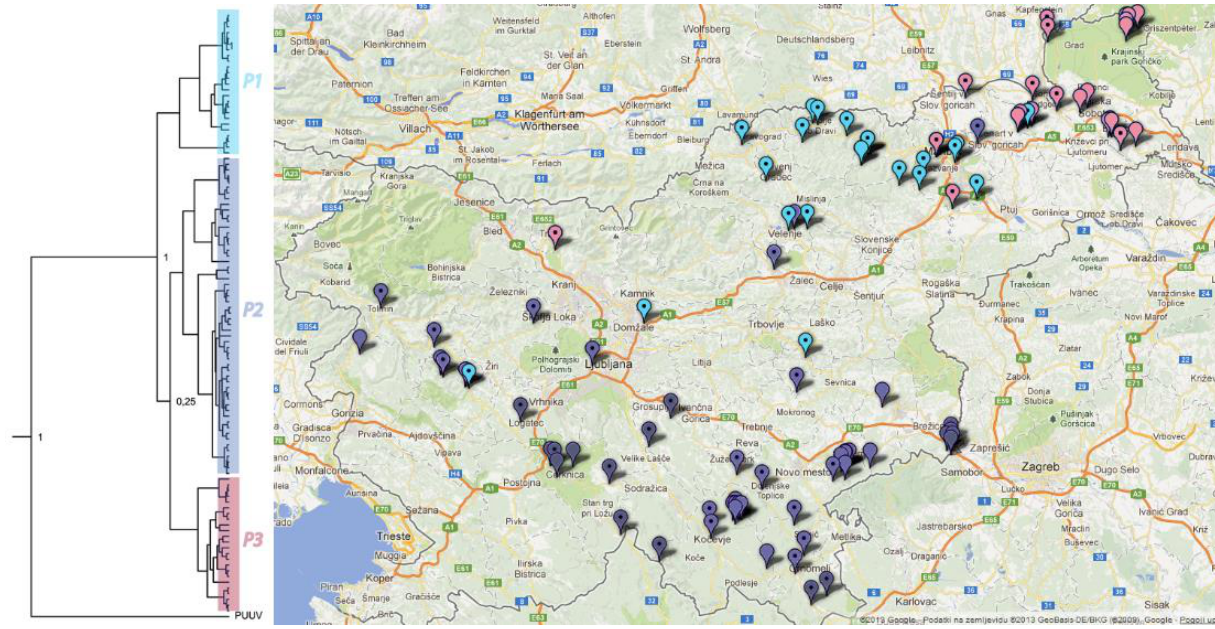
Figure 4. Correlation of phylogenetic and geographical clustering based on PUUV L segment sequences. Phylogeographic analysis showed the presence of three genetic lineages (light blue—P1, dark blue—P2, pink—P3) in voles and patients. The sequences obtained from patients are marked with a